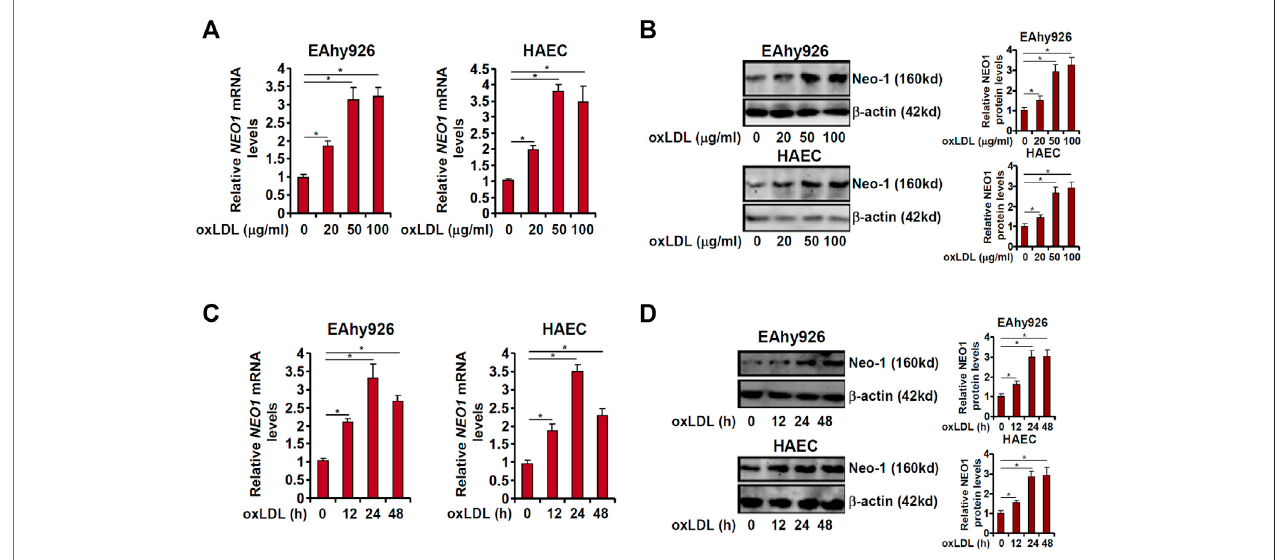
FIGURE1| Neo-1expressionisupregulatedbyoxLDLinendothelialcells. (A,B) EAhy926andHAECsweretreatedwithdifferentconcentrationsofoxLDLfor24 h. Neo-1 expression was examined by qPCR and Western. (C,D) EAhy926 and HAECs were treated withoxLDL (50 μ g/ml) and harvested at indicated time points. Neo-1 expression was examined by qPCR and